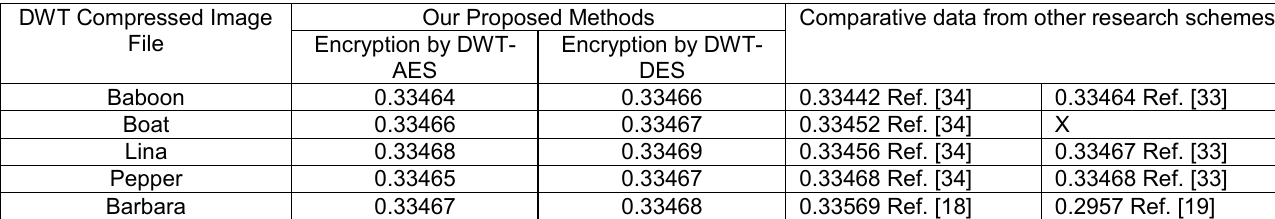
Table 9. Comparison of UACI for different encryption techniques